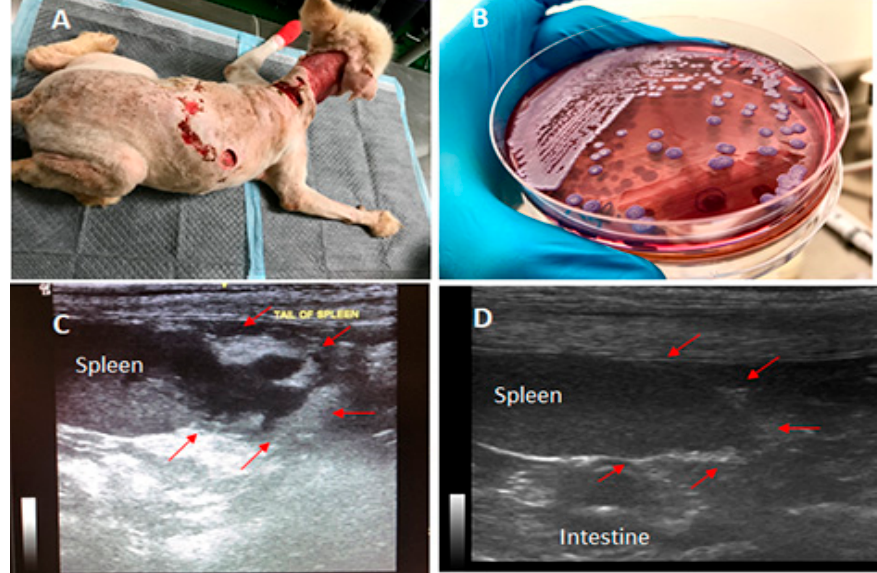
Figure 1. Canine melioidosis: A , showing the massive wounds around the dog’s neck and back observed on the 1 st day at Prince of Songkla University (PSU) Animal Hospital; B , Burkholderia pseudomallei colonies grown on Ashdown’s selective medium; C , the presence of a 2-cm abscess-like mass at the splenic tail confirmed by ultrasonography; and D , the recovery of the splenic tail after 10 weeks of the oral treatment. The arrows point to the areas of abscesses observed in C, which later disappeared after the oral treatment.